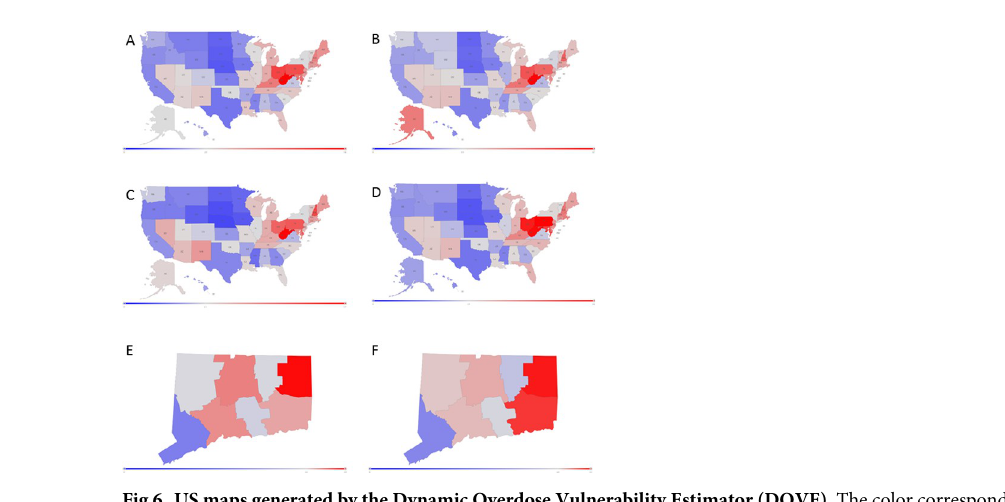
Fig 6. US maps generated by the Dynamic Overdose Vulnerability Estimator (DOVE). The color corresponds to the ODD rate, from low (blue) to high(red). (A) Observed 2017 Overdose Death (ODD) Yearly Rates by State; (B) DOVE Estimated 2017 ODD Yearly Rates by State; (C) Observed July 2017 ODD Rates by State; (D) DOVE Estimated July 2017 ODD Rates by State; (E) Observed County 2017 ODD Yearly Rates in the State of Connecticut; DOVE Estimated County 2017 ODD Yearly Rates in the State of